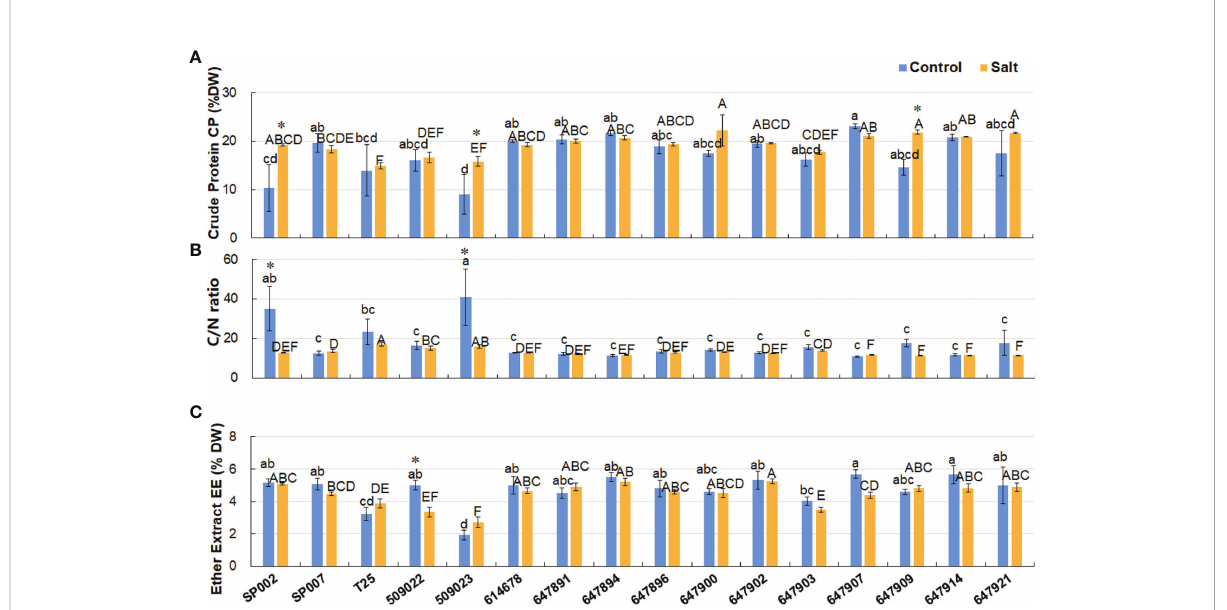
FIGURE 5 Effect of salt stress on crude protein, C/N ratio, and ether extract of 16 seashore paspalum ecotypes. The Crude Protein CP (A) , C/N ratio (B) , and Ether Extract EE (C) of shoots were measured before treatment (control) and after NaCl treatment for 10 d (salt). Means of three independent experiments and standard errors are presented; the same letter above the column indicates no signi fi cant difference at P <0.05. Lowercase letters and uppercase letters respectively indicate signi fi cant comparisons among different ecotypes in the control group and treatment group. * indicates signi fi cant difference at P <0.05 by T-test between salt treatment and control for 16